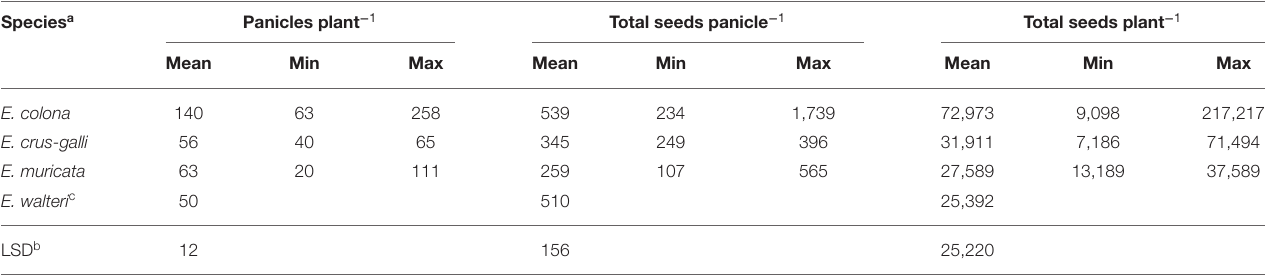
TABLE 1 | Seed production of Echinochloa species in a common garden, averaged across accessions and years, Milo Shult Agricultural Research and Extension Center, University of Arkansas, Fayetteville, AR, USA. Species